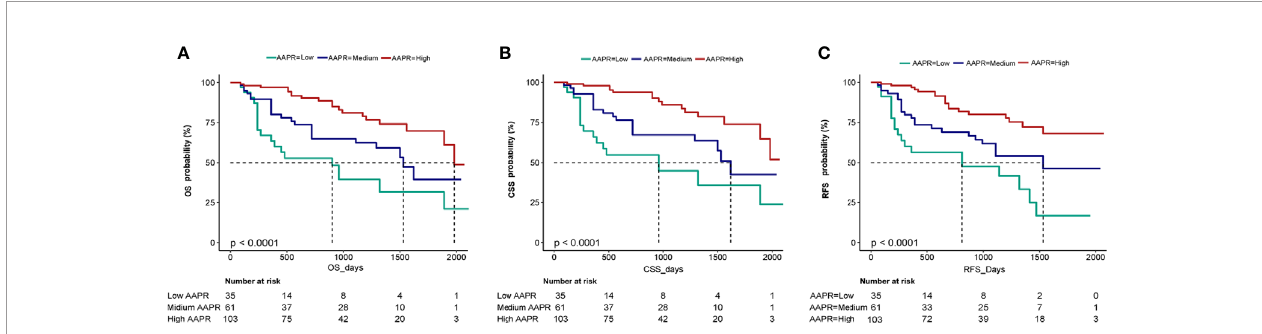
FIGURE 4 | Kaplan-Meier curves of OS (A) , CSS (B) and RFS (C) in BC patients strati fi ed by AAPR. OS, overall survival; CSS, cancer-speci fi c survival; RFS, recurrence-free survival; BC, bladder cancer; AAPR, albumin-to-alkaline phosphatase